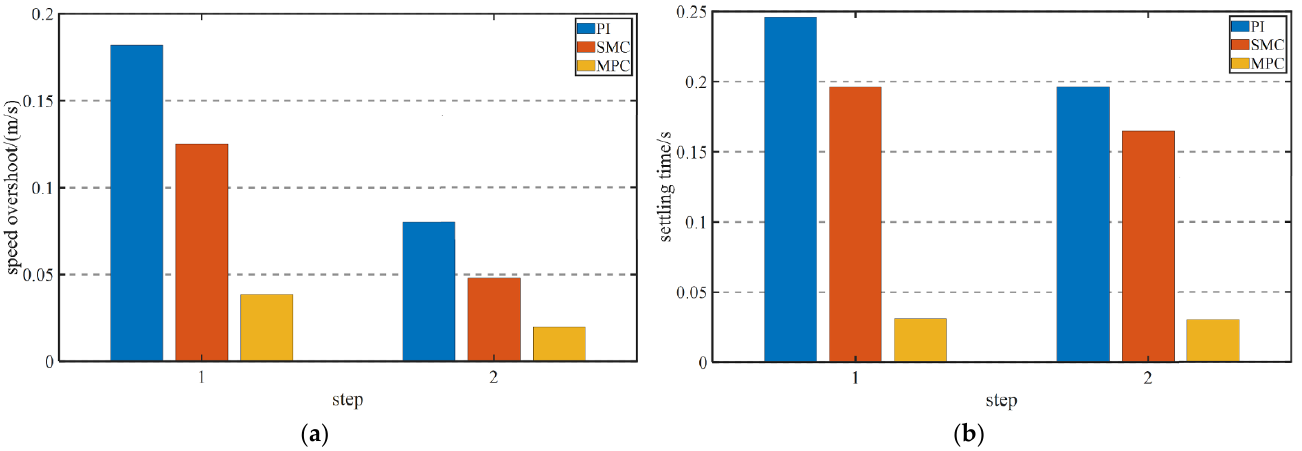
Figure 15. Comparison of the speed-overshoot and settling times of the three controllers under speed variation: ( a ) Speed-overshoot and ( b ) Settling time.